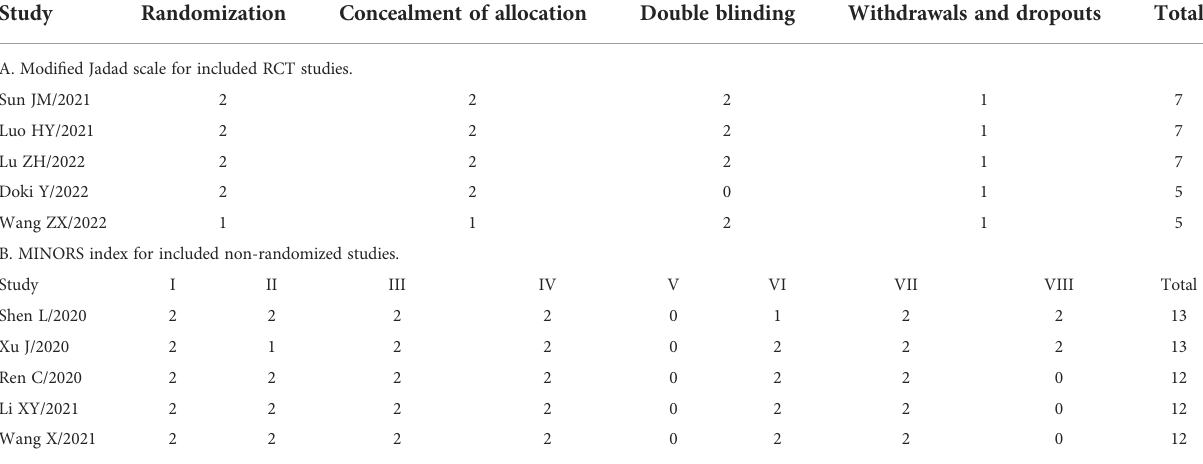
TABLE 2 Quality assessment of included